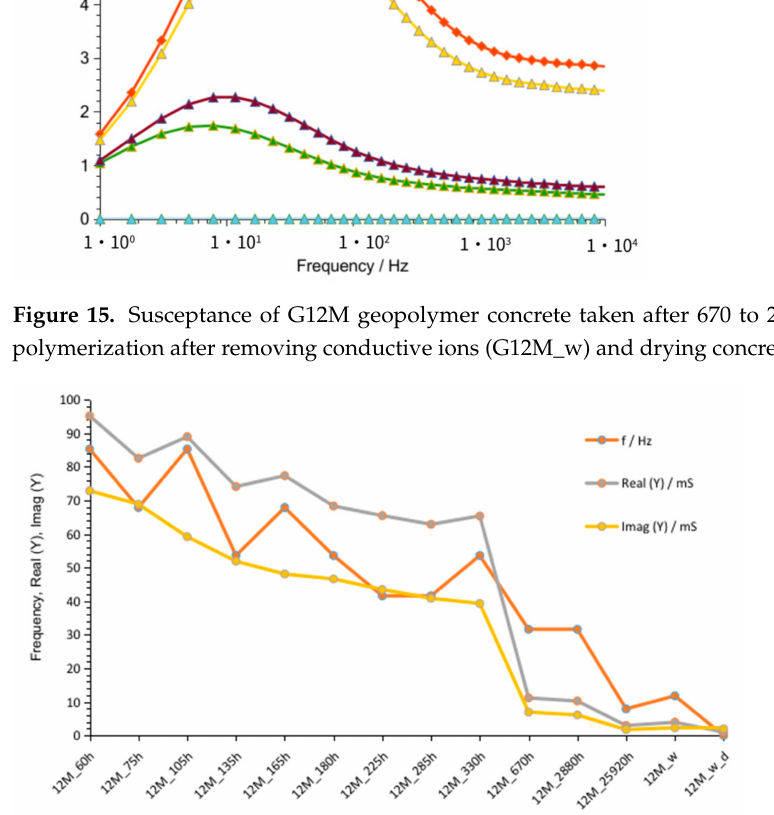
crossing curves frequency—Real (Y) values of Real (Y) at 1 kHz Figure 12 frequency of susceptance maximum